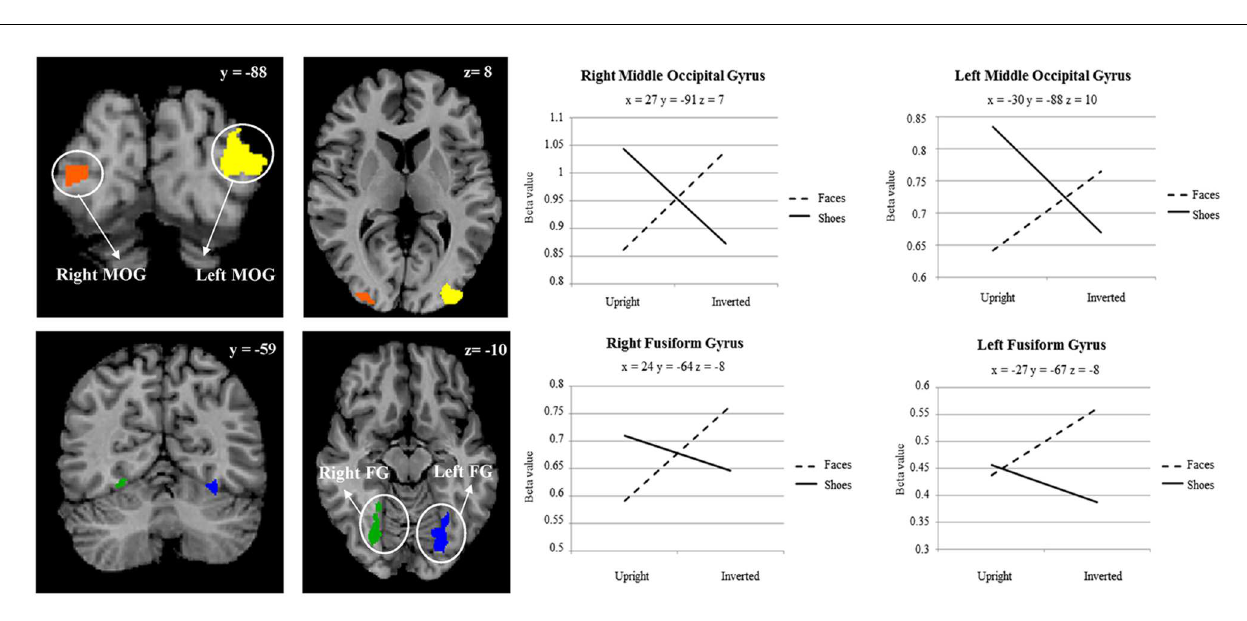
FIGURE 1 | Examples of stimuli from main experiment. Each trial within a block consisted of a simultaneous presentation of two within-category stimuli: Matching upright faces; Different upright faces; Matching inverted faces; Different inverted faces; Matching upright shoes; Different upright shoes; Matching inverted shoes; Different inverted shoes.